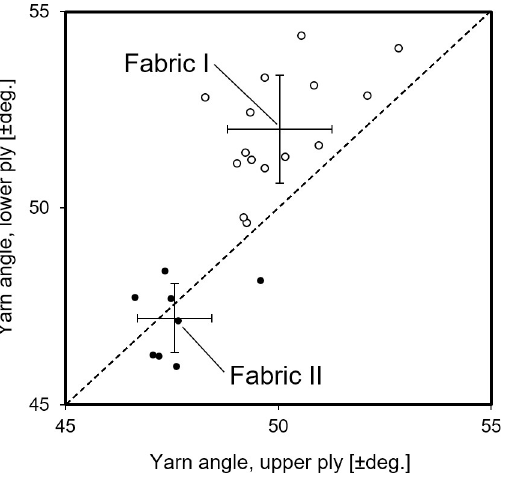
Fig 7. Relationship between measured yarn orientation angles in the lower and upper ply of the two types of biaxial flax fabrics. Crosses indicate means and standard deviations. https://doi.org/10.1371/journal.pone.0234701.g007 data points are above the line. The yarn angles for fabric I in the upper and lower ply are +50.0˚ ± 1.2˚ and -52.0˚ ± 1.4˚ (mean ± stdv.), respectively. Thus, fabric I is deviating from being balanced, and the yarn orientation can be given as +50˚/-52˚. For fabric II, the data points are distributed around the line. The yarn angles for fabric II in the upper and lower ply are +47.6˚ ± 0.9˚ and -47.2˚ ± 0.9˚ (mean ± stdv.), respectively. Thus, fabric II is almost bal-